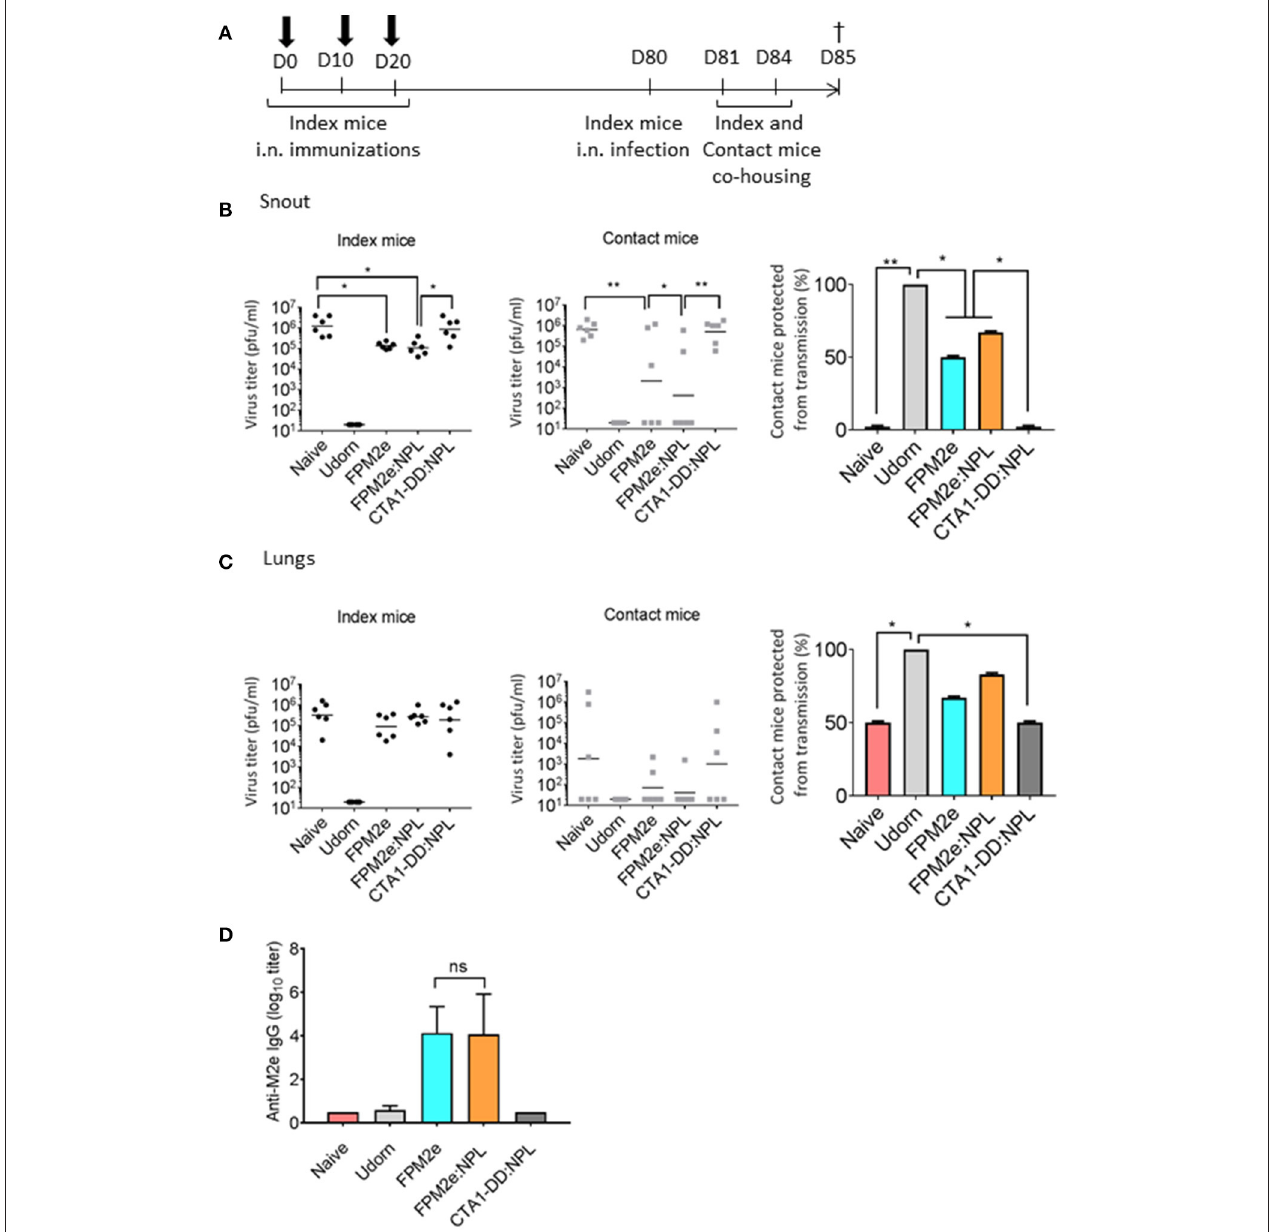
FIGURE 3 | Reduction of viral transmission following intranasal immunizations with the combined NPL vaccine vector. (A) A schematic representation of the experimental protocol used for virus transmission experiments. BALB/c mice (index mice) were immunized three times with 10 days apart with split Udorn virus, 5 µ g per dose of FPM2e alone, FPM2e:NPL, or FP:NPL w/o M2e. Index mice were infected 2–4 weeks after the final immunization with A/Udorn/307/1972 (H3N2) and co-housed with DBA/2 mice (contact mice). (B,C) The viral titers in snouts (B) or lungs (C) of index (left panel) and contact (middle panel) mice and the mean percentages of contact mice protected from virus transmissions (right panel) are shown. (D) M2e-specific IgG antibodies in serum were measured by ELISA in index mice and the r e sults are given as mean log 10 titers ± SD. These are representative results from 3 experiments giving similar results and the statistical significance was calculated using unpaired t -test and p -values are * p < 0.05 and ** p <